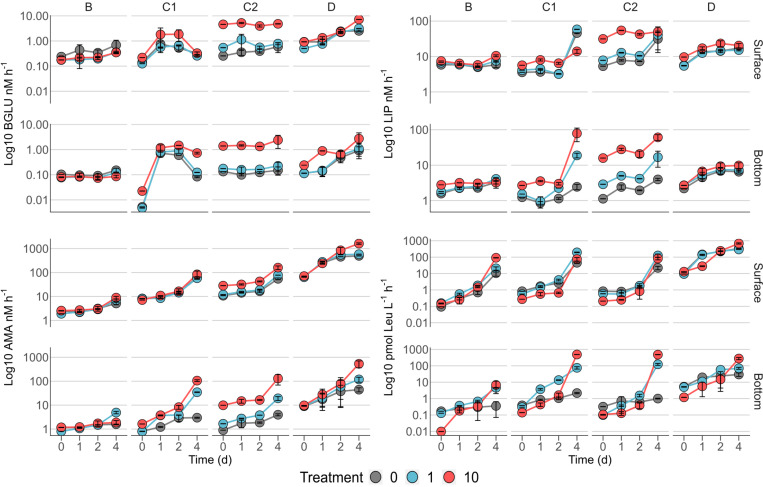
Time courses of β-glucosidase (BGLU), lipase (LIP), leucine-aminopeptidase activities (AMA), and heterotrophic carbon production (HCP). 0, controls; 1, 1 μg L–1 Chl a; and 10, 10 μg L–1 Chl a. To ease comparison, metabolic rates are plotted on Log Y-axes, which are differentially scaled. Error bars represent the standard deviation of two experimental replicates; where not visible, they are embedded in the symbol.